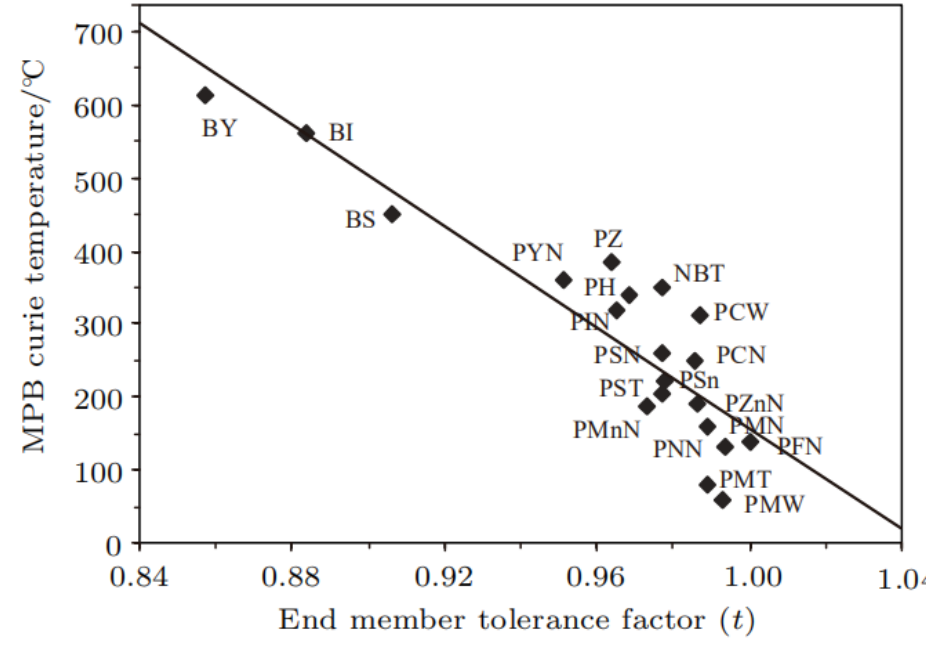
Figure 3. The relationship of tolerance factor t and Curie temperature of MPB components in (1-x)ABO 3 -xPbTiO 3 (ABO 3 components) solid solution. Reproduced with permission from Ref. [37]. Copyright 2001 American Chemical